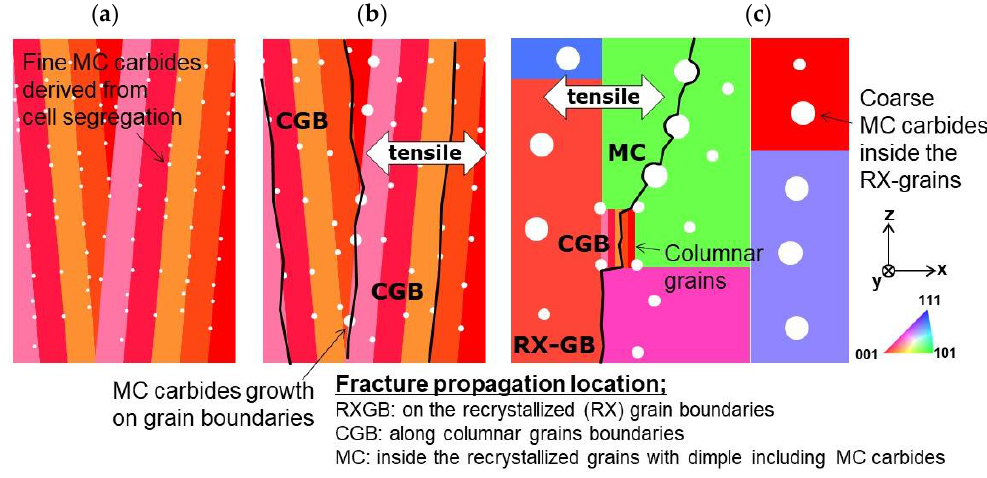
Figure 7. Schematics of microstructure evolution during heat treatment. ( a ) As-built; ( b ) Heat-treated under the recrystallized Temperature (L-HT); ( c ) After recrystallization (H-HT). In the as-built state, the cell-solidified microstructure along the z -direction via the LPBF process is shown in Figure 7a. Since Nb and Ta, which are MC carbide-forming elements, segregate on the cell boundaries and dendrite boundaries [46,47], the fine white particles at the cell boundaries in the AB materials observed in the BSE image of Figure 3a′ are suggested to be fine MC carbides. These fine MC carbides frequently precipitated throughout the cell boundaries.